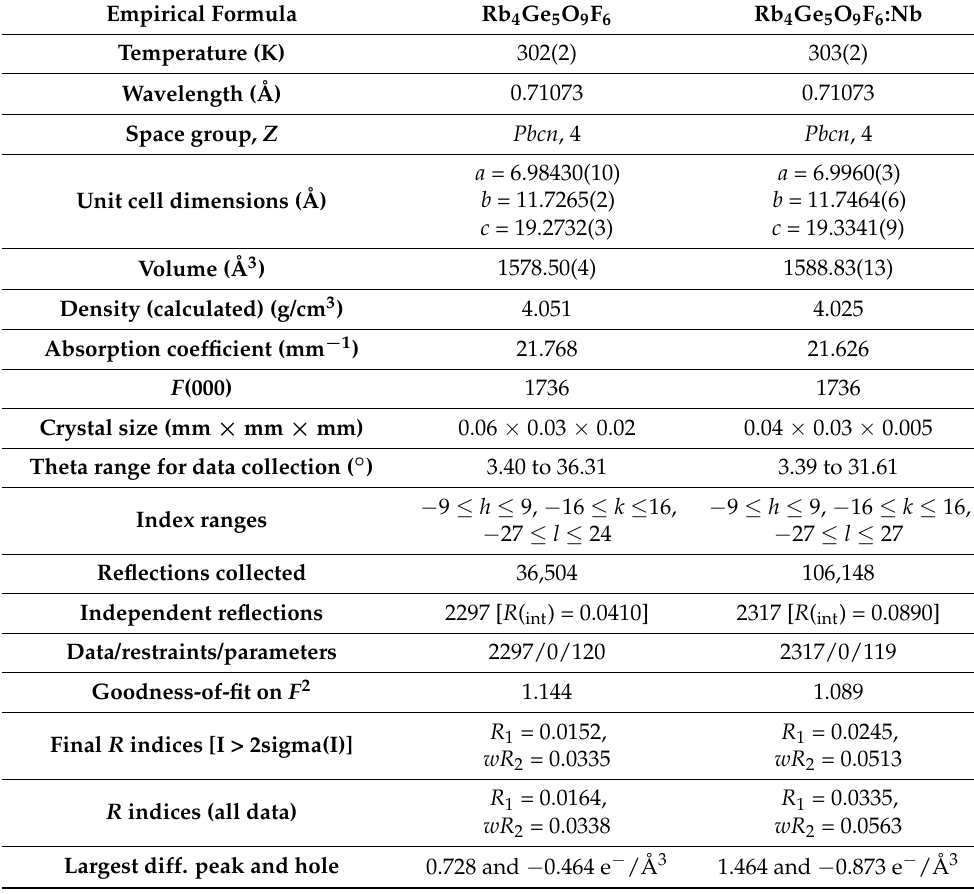
Table 1. Crystallographic data for Rb 4 Ge 5 O 9 F 6 and Rb 4 Ge 5 O 9 F 6 :Nb.